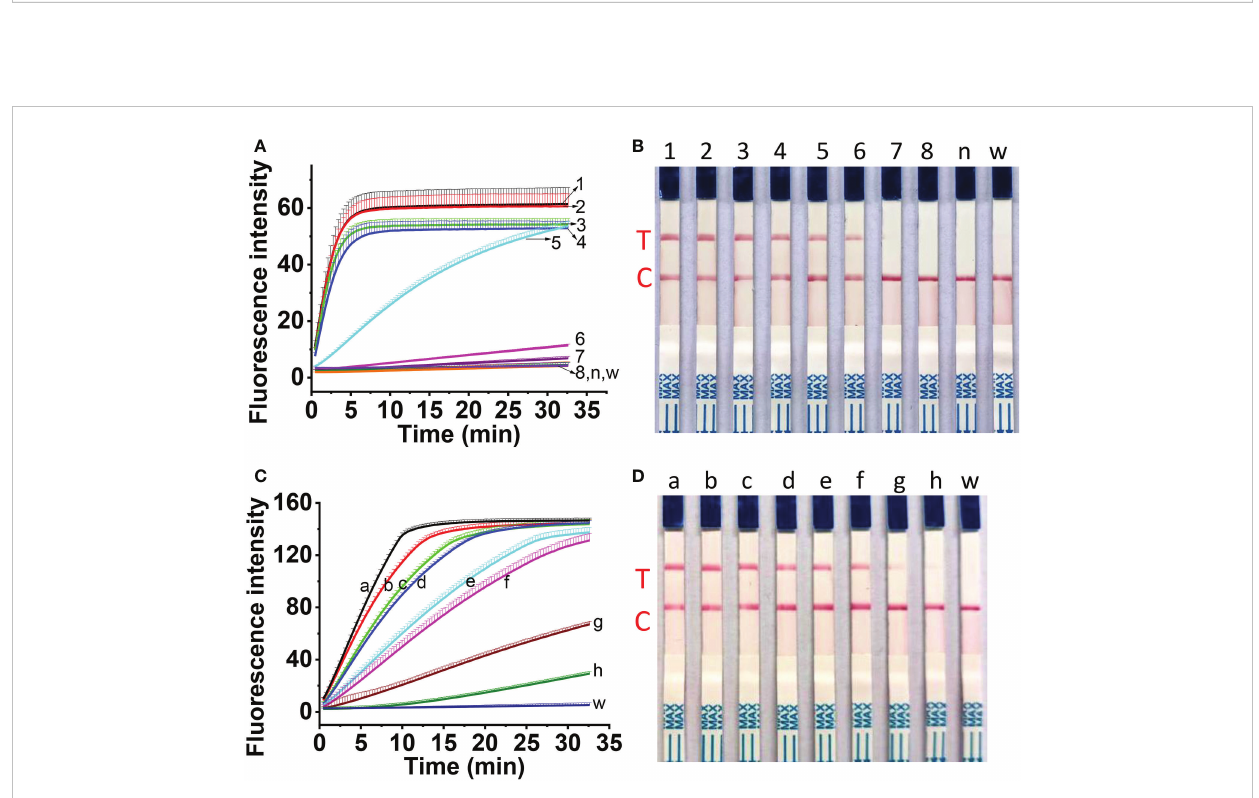
FIGURE 7 Sensitivity assessment of one-tube one-step RT-RAA/Cas12a-based detection for 10-fold diluted total RNA (A, B) and for 10-fold diluted plasmid DNA containing coat protein gene (C, D) . (A, B) No.1 ~ 8 indicated the amount of total RNA. 1, 96 ng; 2, 9.6 ng; 3, 0.96 ng; 4, 96 pg; 5, 9.6 pg; 6, 0.96 pg; 7, 96 fg; 8, 9.6 fg; n, RNA from healthy maize leaves; w, water. (C, D) a ~ h indicated the copies of plasmid containing the coat protein gene of MCMV. a, 2.5 × 10 7 copies; b, 2.5×10 6 copies; c, 2.5×10 5 copies; d, 2.5×10 4 copies; e, 2.5×10 3 copies; f, 2.5×10 2 copies; g, 2.5×10 1 copies; h, 2.5 copies; w,